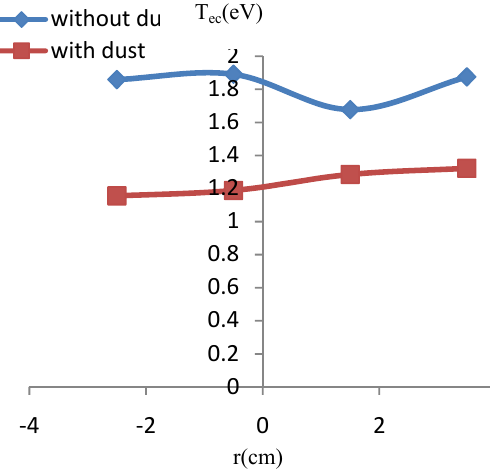
Fig. 10: Effect of Al dust on the radial profile of cold electron